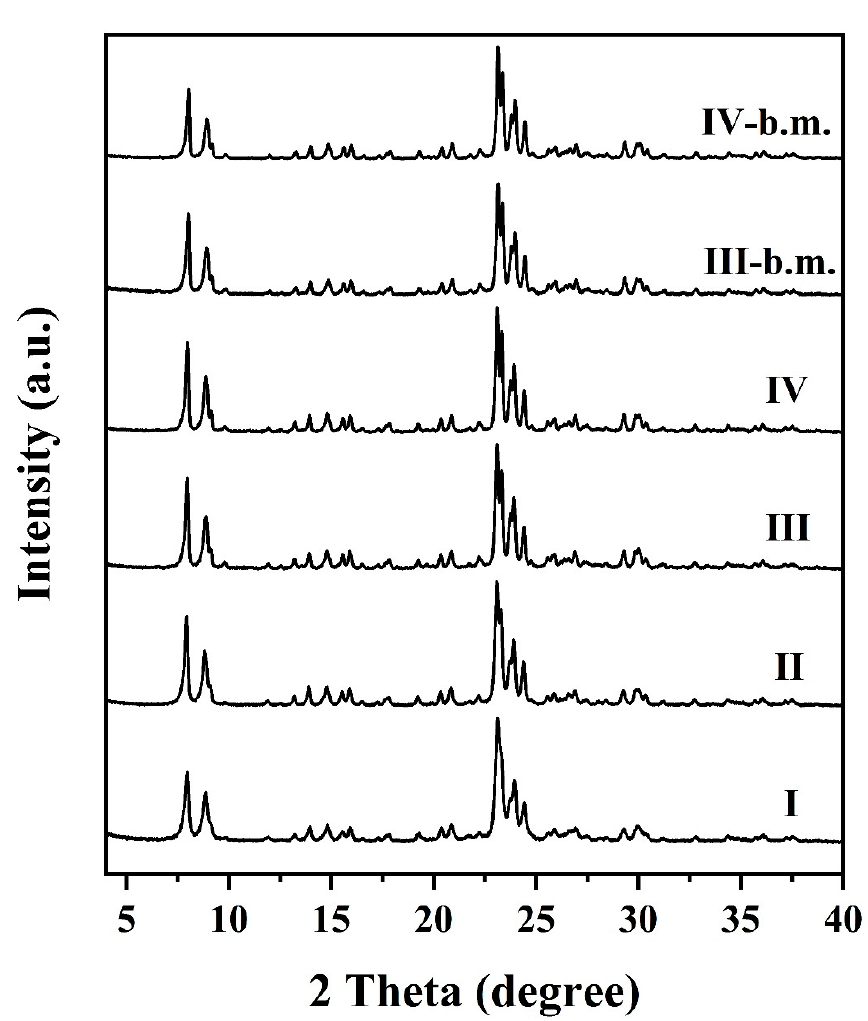
Figure 1. The X-ray diffraction patterns of ZSM-5 zeolites I – IV, III-b.m., and IV-b.m. Table 1. Structural and textural properties of ZSM-5 zeolites I – V, III-b.m., and IV-b.m.